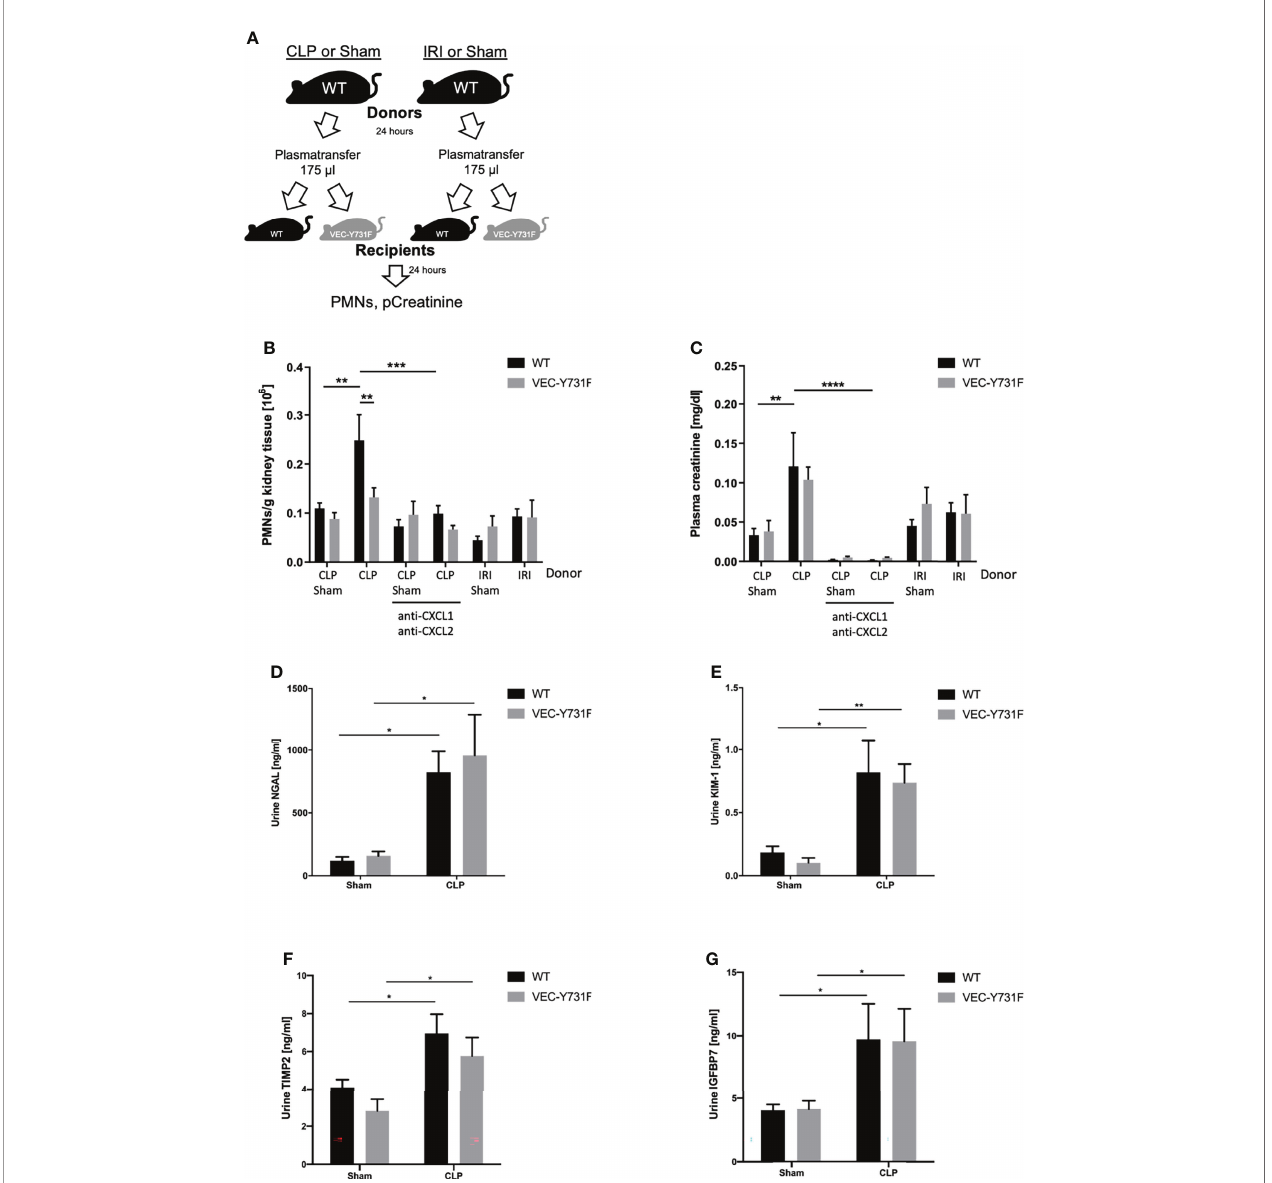
FIGURE 5 | ThepathogenesisofCLP-inducedAKIreliesonproin fl ammatorymediators.Sham,CLP,orIRI-surgerywasperformedinWTmiceandbloodsamplesforplasma isolationwereobtainedafter24hours.175µlplasmafromsham-,IRI-orCLP-operatedWTmicewasinjectedintravenouslyintoWTandVEC-Y731Fmice. (A) Illustrativeschemeof plasmatransferexperiments.24hoursafterplasmainjectiontheneutrophilrecruitmentintothekidneyswasanalyzedby fl owcytometry (B) andplasmacreatinineconcentrationswere analyzedbyphotometry (C) .CLPtransferexperimentswereperformedwithsupplementedanti-CXCL1andanti-CXCL2(4µg/mouse,R&DSystems)Theconcentrationsofthe biomarkersNGAL (D) ,KIM-1 (E) ,TIMP2 (F) andIGFBP7 (G)